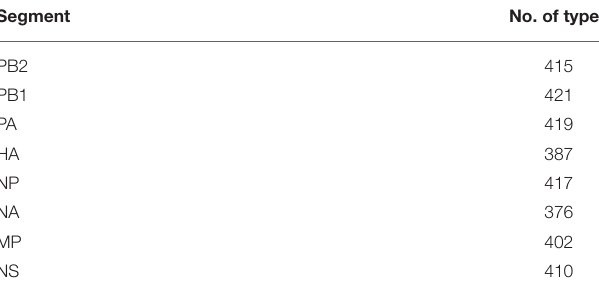
TABLE 1 | The number of types for each